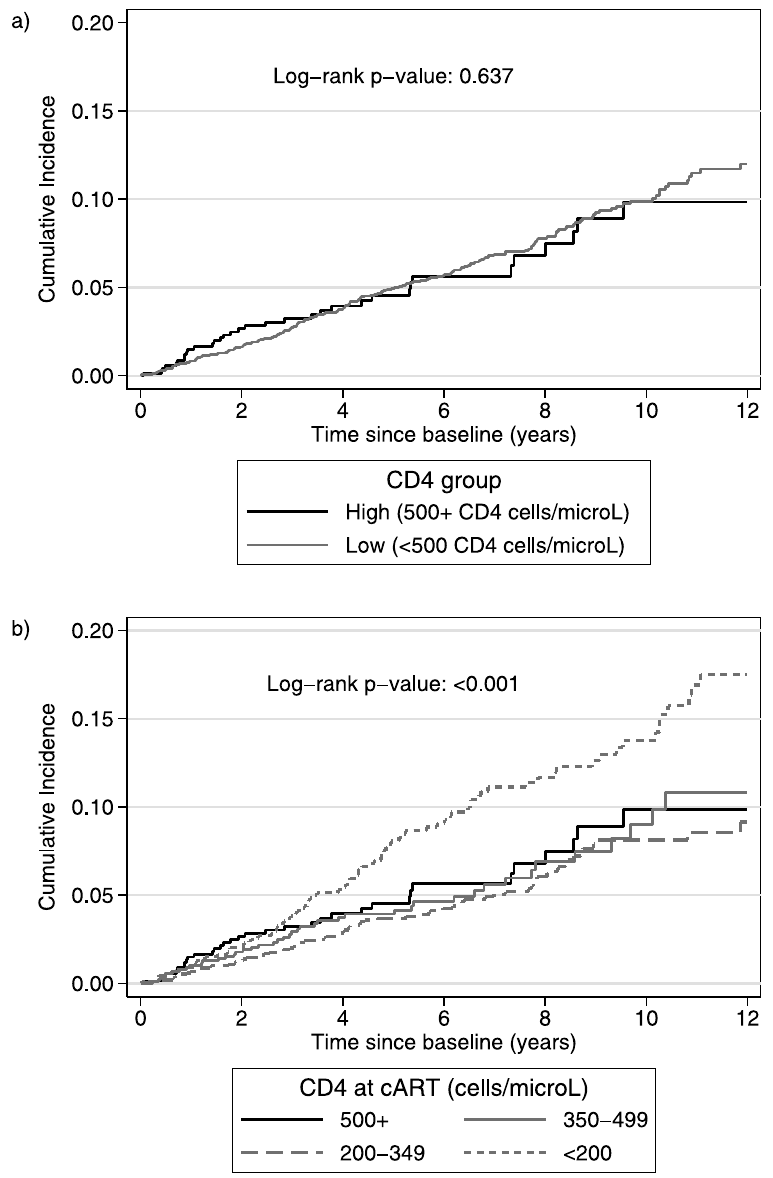
Fig 2. Cumulative probability of primary endpoint (Serious AIDS, Serious non-AIDS or death from any cause) by a) CD4 group (“High” i.e. those who started ART with 500+ and “Low” i.e. those who started ART with < 500 CD4 cells/ μ l) and b) CD4 group with further stratification of the “Low” CD4 group according to CD4 at ART initiation. Baseline is the date of ART initiation (“High” CD4 group) or the date of first reaching 500 CD4 cells/ μ l (“Low” CD4